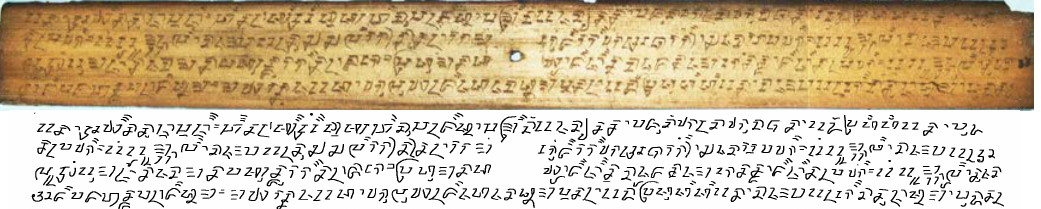
Figure 13. Sundanese manuscript with binarized ground truth image.